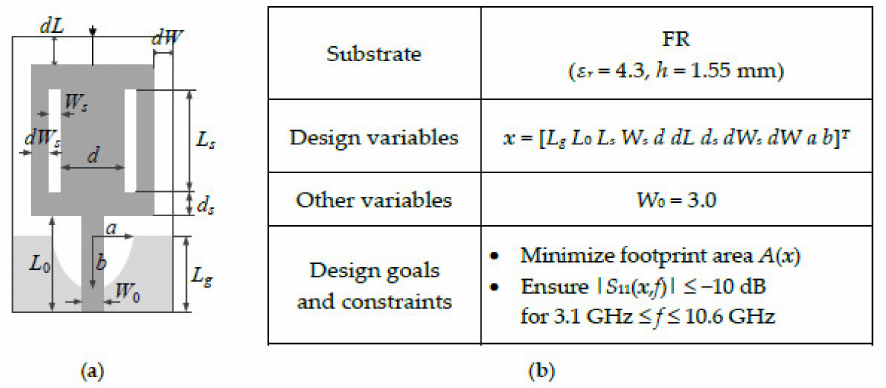
Figure 11. Broadband antenna [57]: ( a ) geometry, ( b ) essential